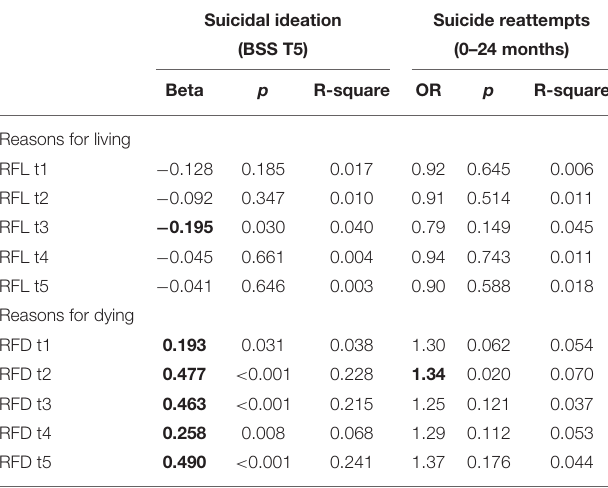
TABLE 4 | Associations between RFD/RFL and suicidal ideation (BSS Score) and number of suicide